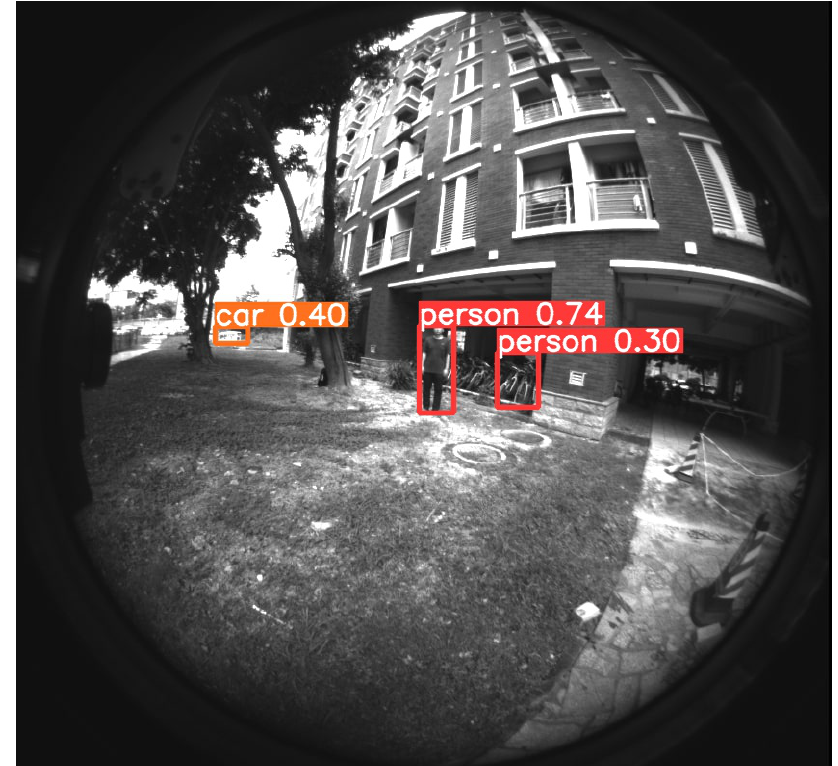
Figure 9. The ordinary person-detection